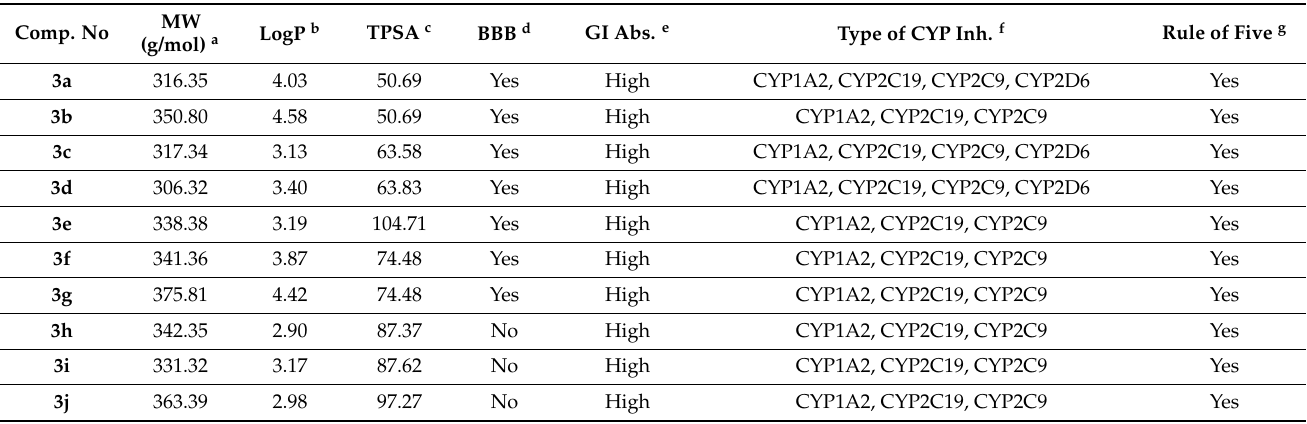
Table 5. Drug-like properties of 1a-1o , 2a-2n comps. calculated by the Swiss ADME online software